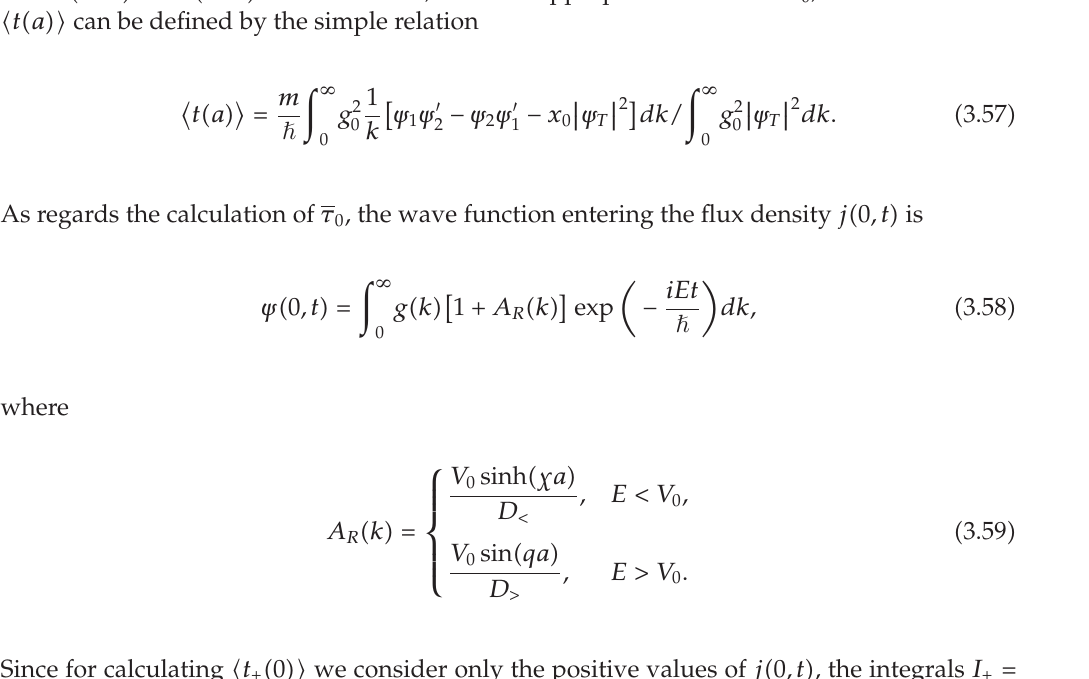
From (cid:2) 3.51 (cid:3) and (cid:2) 3.56 (cid:3) it follows that, with an appropriate choice of x 0 , the mean